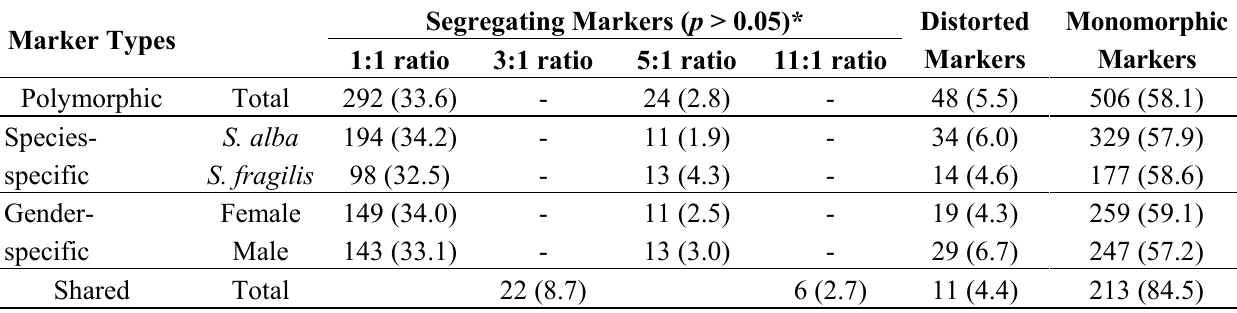
Table 1. Information on the inheritance patterns observed for single-dose and multiple-dose marker alleles. Marker types refer to the parental individuals whereas segregating, distorted and monomorphic markers refer to the F1